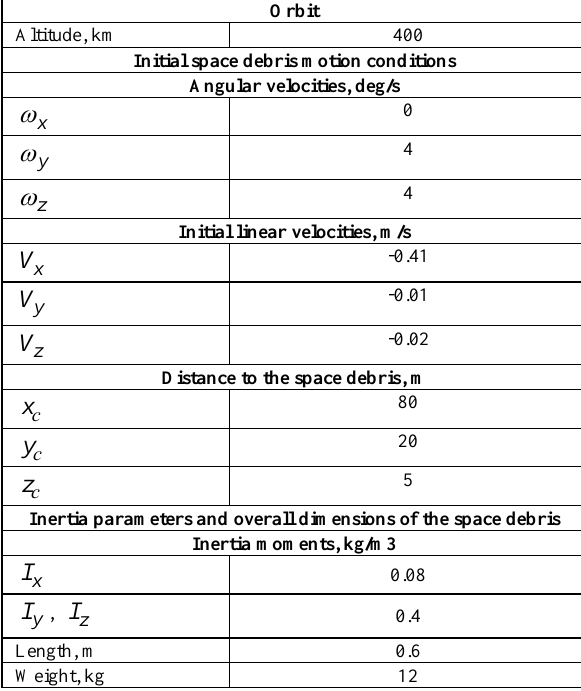
Table 1 . Initial simulation